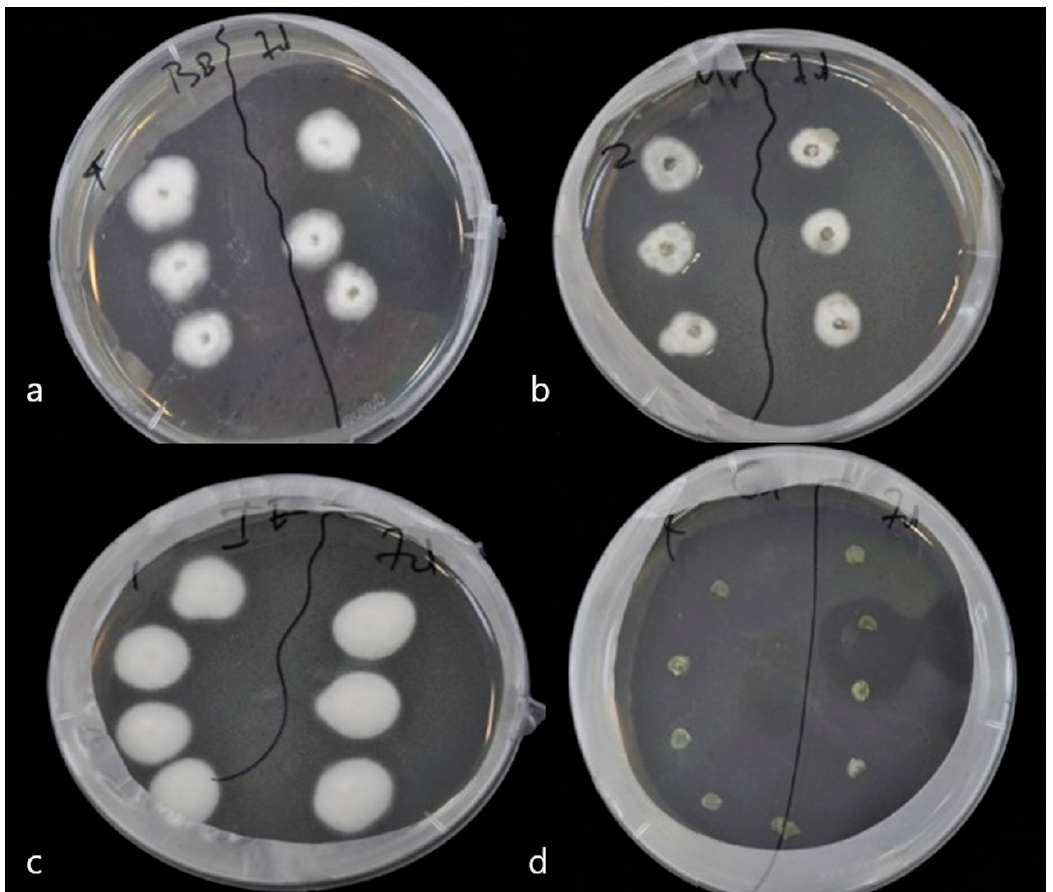
Figure 2. Detection of endophytic entomopathogenic fungi on treated and untreated pepper plants. The fungus was fully developed after 11 days, on Sabouraud dextrose agar. ( a ) B. bassiana , ( b ) M. anisopliae, ( c ) I. fumosorosea , and ( d ) Control.